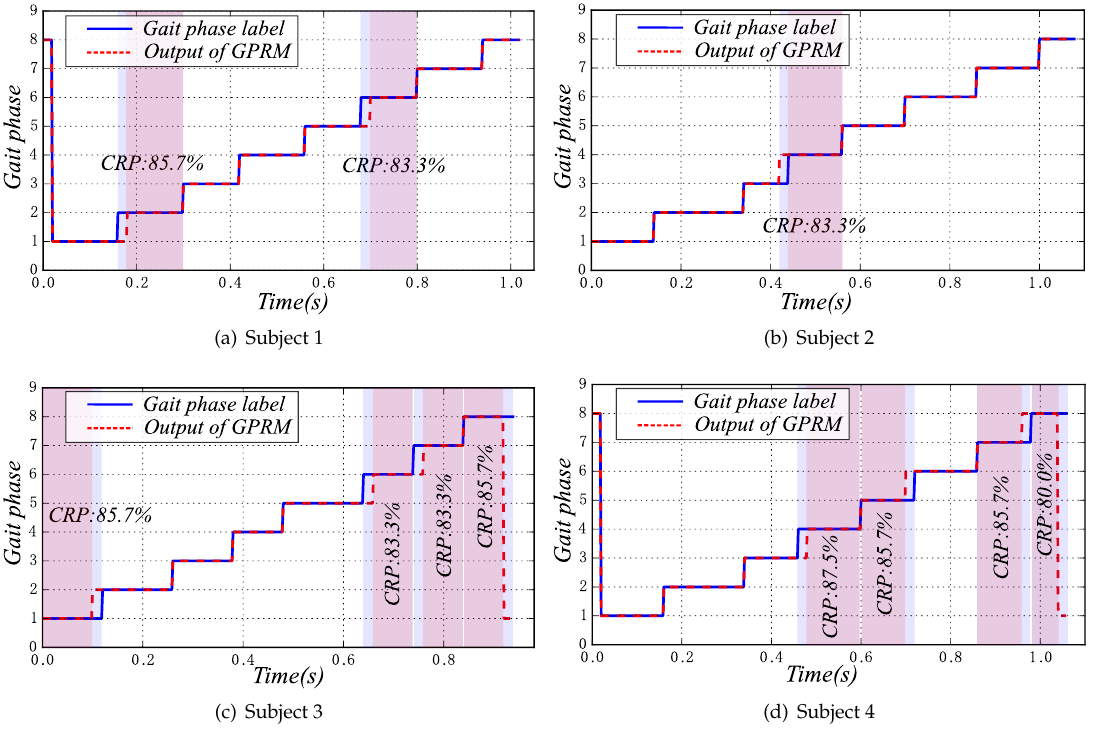
Figure 14. The gait phase recognition results of four cycles, which are respectively from four subjects of the test set. GPRM, gait phase recognition